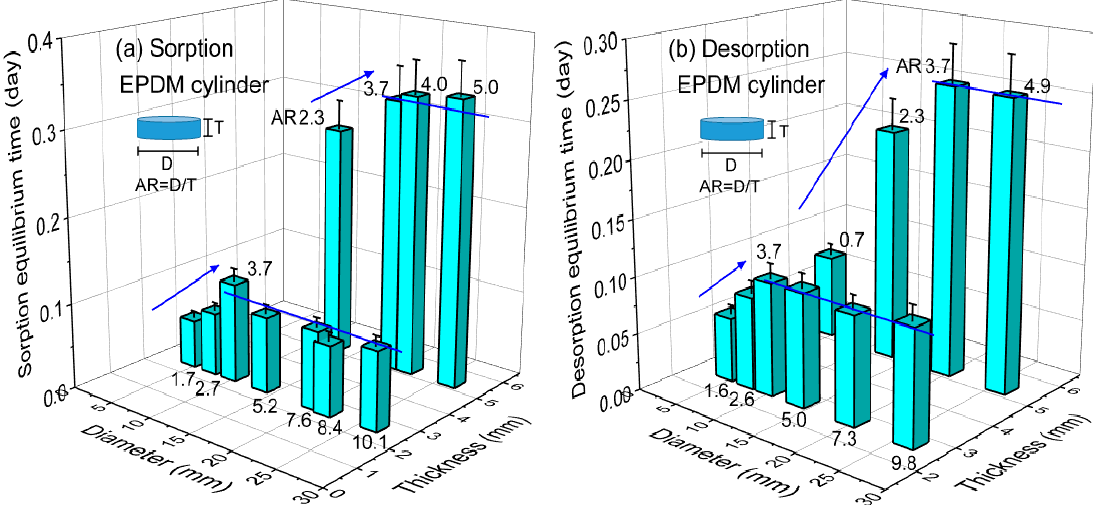
Figure 8. Three-dimensional plot of ( a ) sorption and ( b ) desorption equilibrium time versus volume for EPDM. The number at the top of the bar indicates the aspect ratio (AR = D/T) of the cylindrical rubber. D and T indicate the diameter and thickness, respectively, of the cylindrical-shaped specimen. The blue slanted lines with arrows indicate the linear increase in equilibrium time versus thickness. The blue horizontal lines indicate constant equilibrium time versus